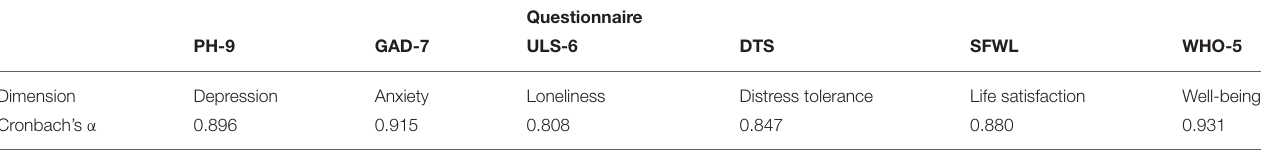
TABLE 3 | Internal consistency of the questionnaires.